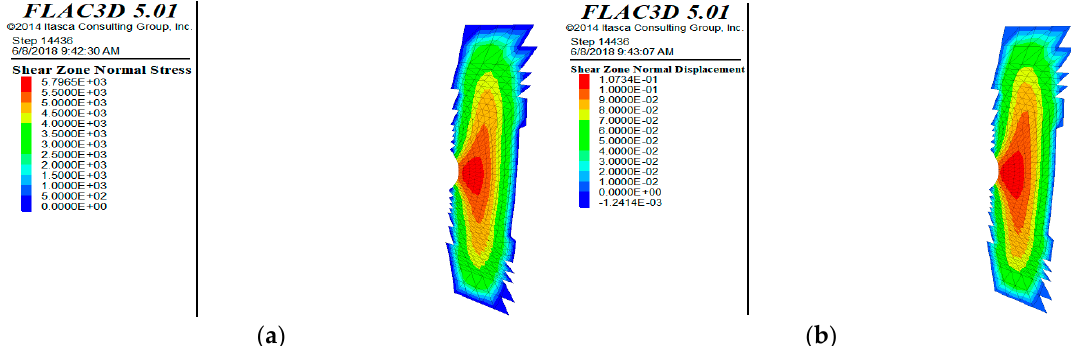
Figure 15. Contour shear zone: ( a ) normal stress and ( b ) normal displacement.